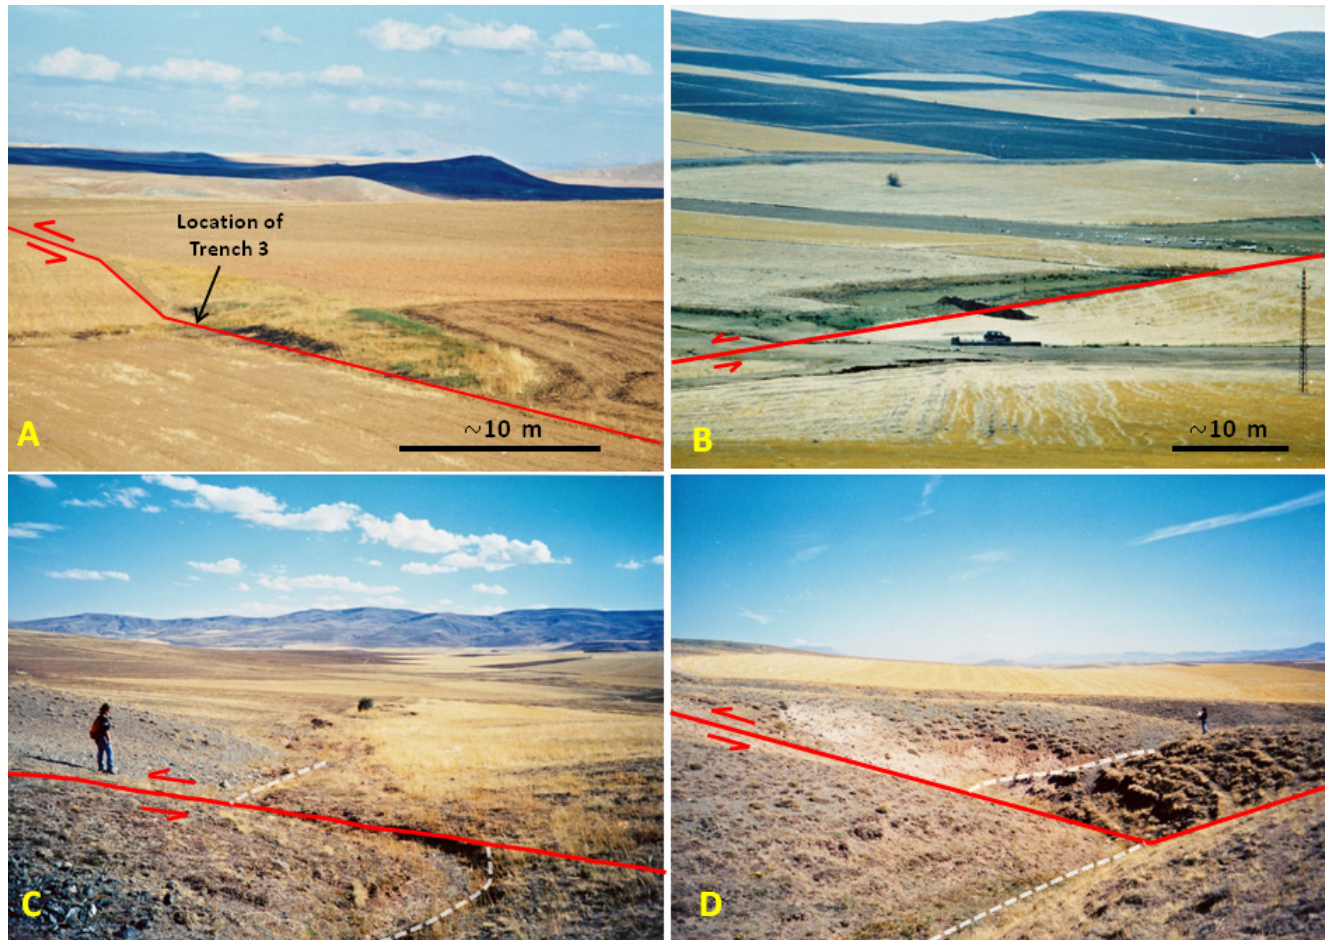
Figure 4. Morphological indicators of Tecer Fault. A. Linear scarp to the south of Bogazdere (looking to the SE, towards the site of Trench-3). B. Linear depression to the west of Alaca (looking to the NE). C. Offset (6 ±0.5 m) of stream to the north of Alaca (looking to the NW). D. Offset (12 ±1 m) of stream to the NW of Alaca (looking to the NW). Dashed white lines represent the approximate bases of the gullies. Geologist in (C) and (D) for scale (1.75 m